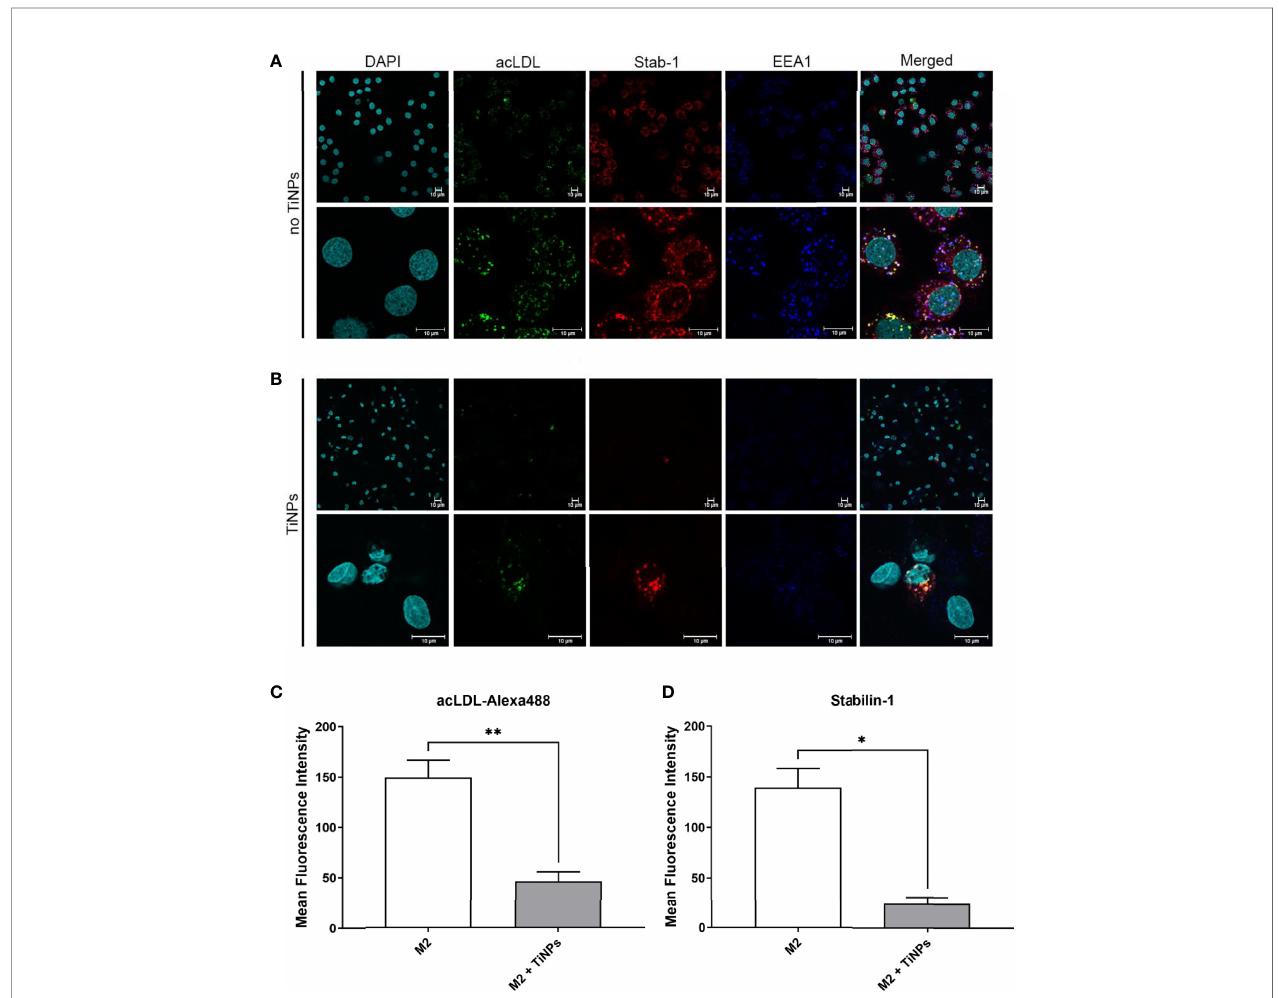
FIGURE 4 | Confocal microscopy analysis of the suppressive TiNP effect on the stabilin-1-mediated endocytosis in healing M2 macrophages. M2 macrophages were exposed to stabilin-1 ligand acLDL-Alexa488 at a concentration of 5 µg/mL for 30 minutes. M2 derived from monocytes of 3 individual donors were used for each type of analysis. (A) Representative images of confocal microscopy analysis of M2 in absence of TiNPs. (B) Representative images of confocal microscopy analysis of M2 in presence of TiNPs. Visualization of nuclei was performed using DAPI (visualized in cyan). acLDL-Alexa488 is shown in green. Stabilin-1 was detected by RS1 rabbit polyclonal antibody and Cy3-conjugated anti-rabbit secondary antibody (visualized in red). EEA1 was detected using anti-EEA1 mouse antibody and Alexa-647-conjugated secondary antibody (visualized in blue). Representative images of single cells are shown for M2. Scale bars: 10 µm. (C) Quanti fi cation of confocal microscopy images for the internalized acLDL-Alexa488 and (D) quanti fi cation of confocal microscopy images for expression of stabilin-1. For every 3 individual donors, 5 different fi elds of images were assessed using Qupath open source program. The mean fl uorescence intensity was calculated by averaging the intensity of each cell per condition. Error bars indicate the means standard error of the results. *p < 0.05, **p <